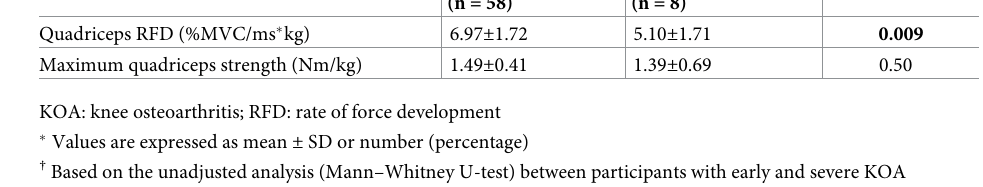
Values are expressed as mean ± SD or number (percentage) † Based on the unadjusted analysis (Mann–Whitney U-test) between participants with early and severe